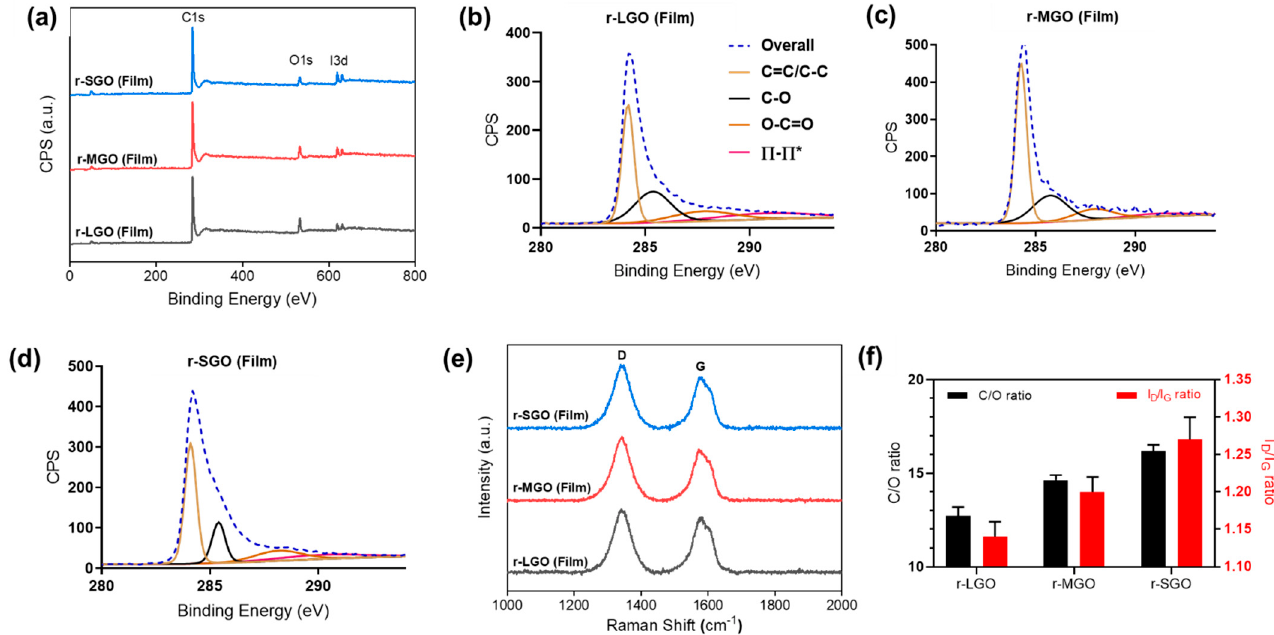
Figure 3 . Chemical composition and physical characterization of rGO films. ( a ) General survey XPS spectra of rGO films. r-SGO (blue), r-MGO (red), and r-LGO (black). ( b – d ) XPS C1s deconvolution spectra of r-LGO, r-MGO, and r-SGO, respectively. ( e ) Raman spectra of rGO films. ( f ) Correlation between C/O, I D /I G ratio, and various rGO films. All GO films were reduce using HI acid as reductant. Error bars represent standard error of mean (SEM), n = 3.